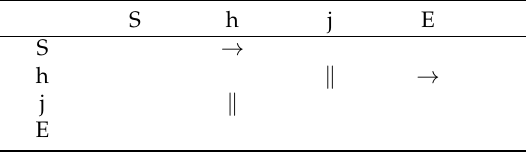
Table 4. Pattern Relation Table T hj .